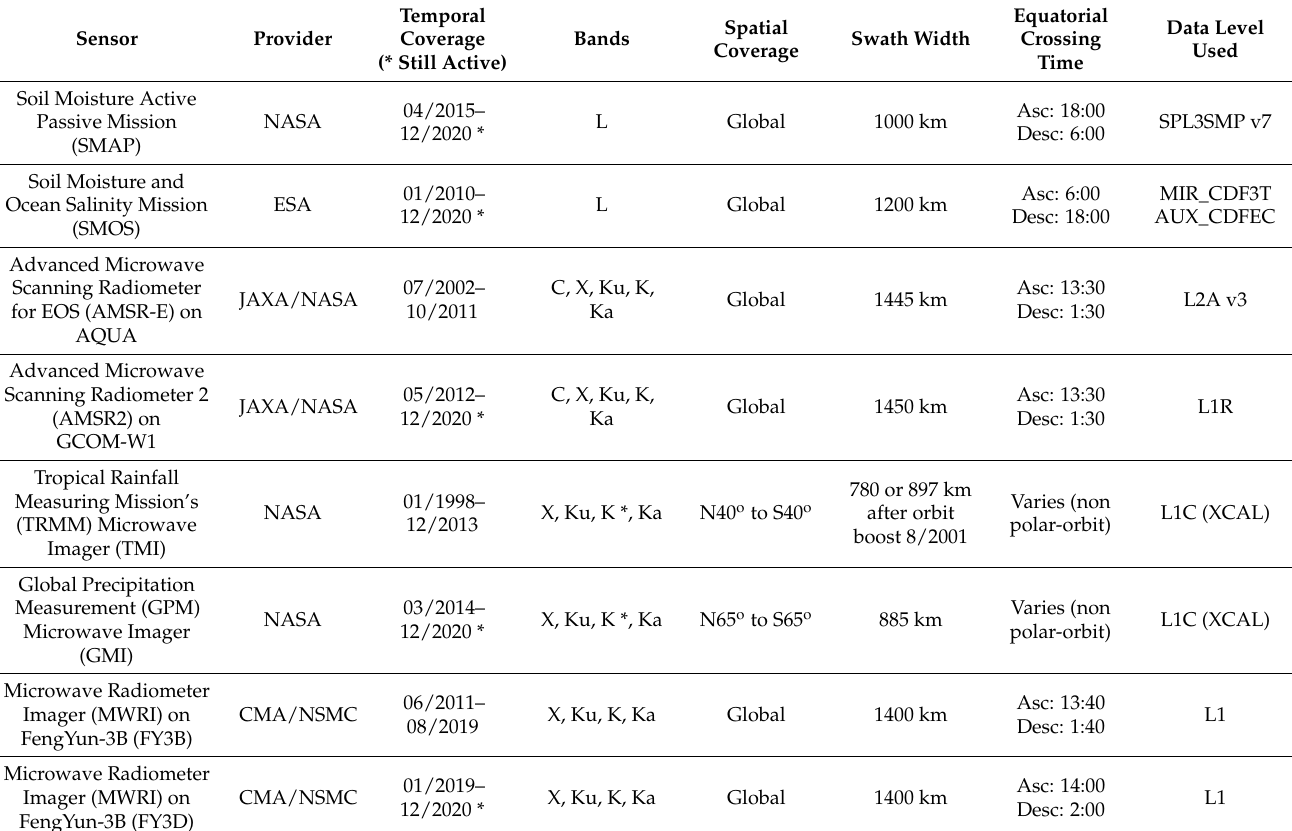
Table 1. Overview and characteristics of used passive microwave satellite sensors. An asterisk indicates that only V- polarization is available for that band.